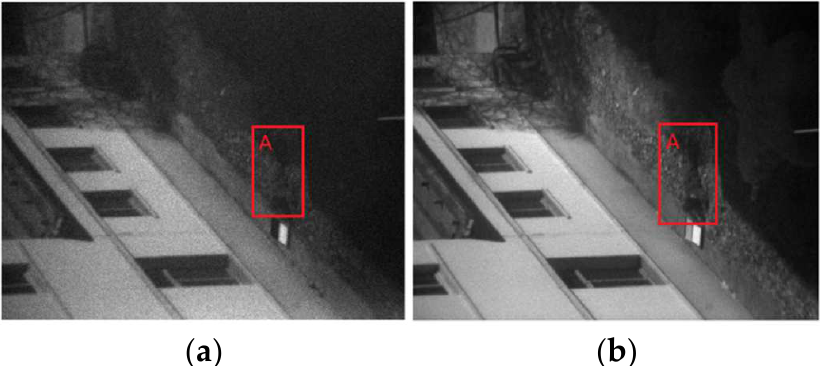
Figure 9. Test results of a Mengshi vehicle.